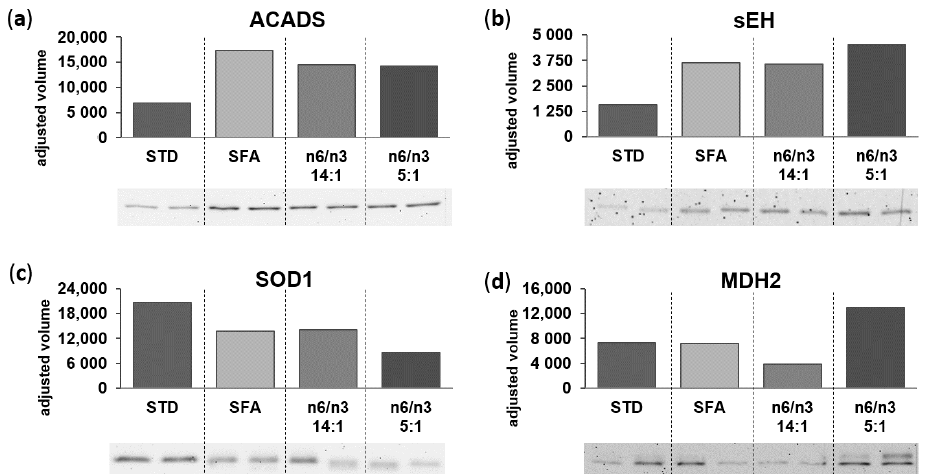
Figure 6. Validation of proteomic data obtained using 2-DE combined with MALDI-ToF MS. Protein expression levels of ( a ) short-chain specific acyl-CoA dehydrogenase, mitochondrial—ACADS ( b ) bifunctional epoxide hydrolase 2—sEH ( c ) superoxide dismutase 1—SOD1 ( d ) malate dehydrogenase, mitochondrial—MDH2. Western blots represent the murine myocardium from the control (STD) and experimental groups: SFA, 14:1 and 5:1.